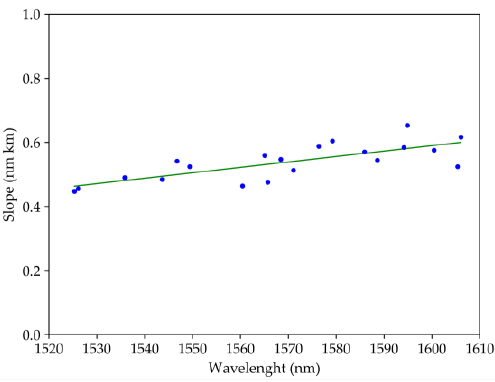
Figure 6. Slope of various extremes of the spectrum as a function of the wavelength where these extremes are located at the smallest curvature.